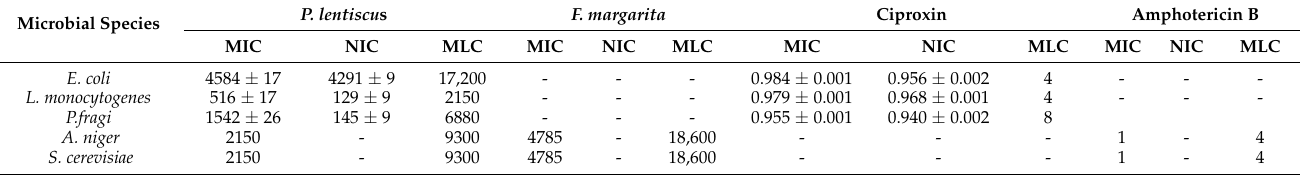
Table 2. MIC, NIC, and MLC (mg/L) of P. lentiscus and F. margarita EOs against E. coli , L. monocytogenes